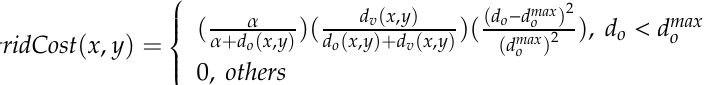
Figure 5. Obstacle binary map of cutting zone. The black area is the obstacle area, which retains the typical details of the four-direction scanning binary maps.